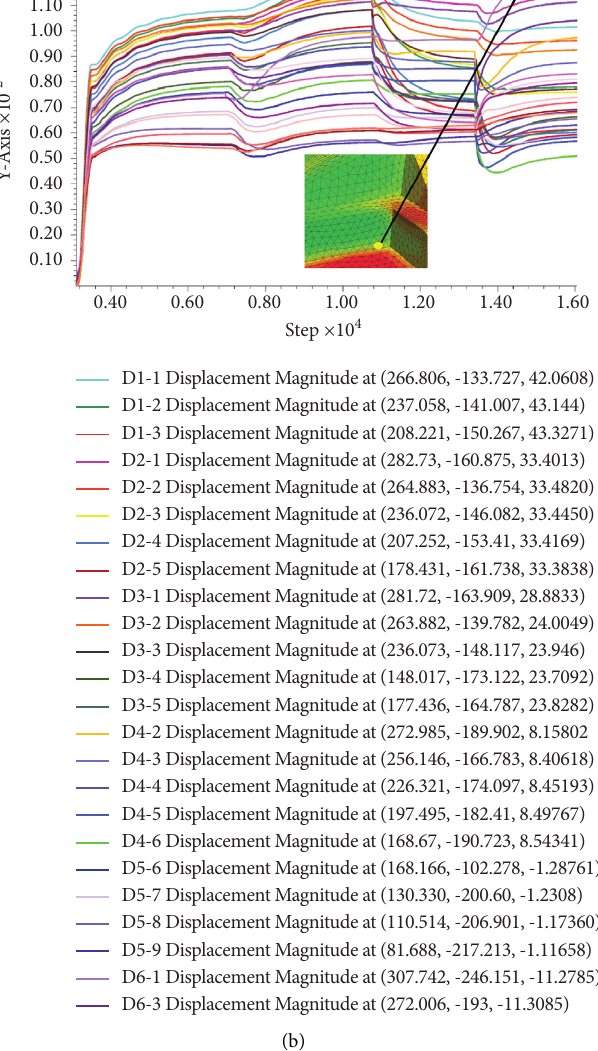
Figure 16: Stress strain monitoring curve. (a) Stress monitoring curve and (b) strain monitoring curve.